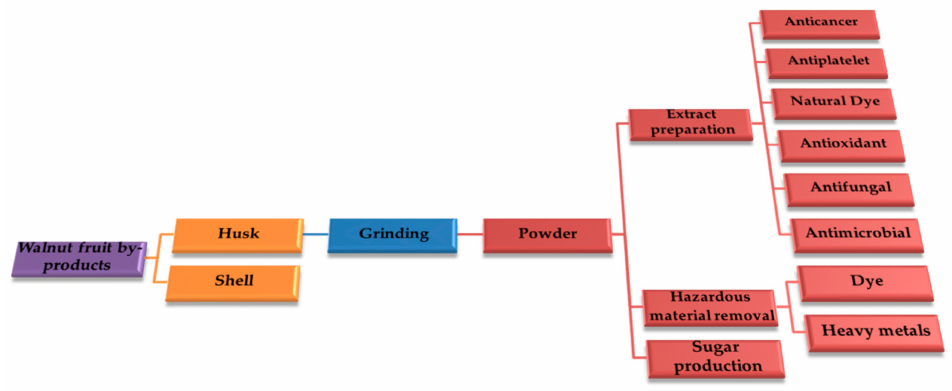
Figure 15. Schematic illustration of walnut fruit by-products, as well as the processing and main applications of walnut green